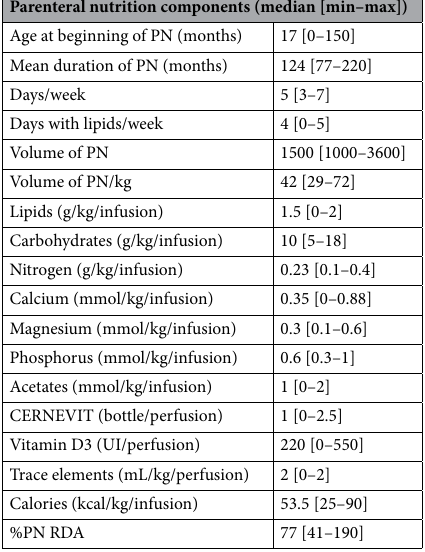
Table 2. Content of parenteral nutrition. Results as median [min–max], PN: parenteral nutrition, RDA: recommended dietary allowances.